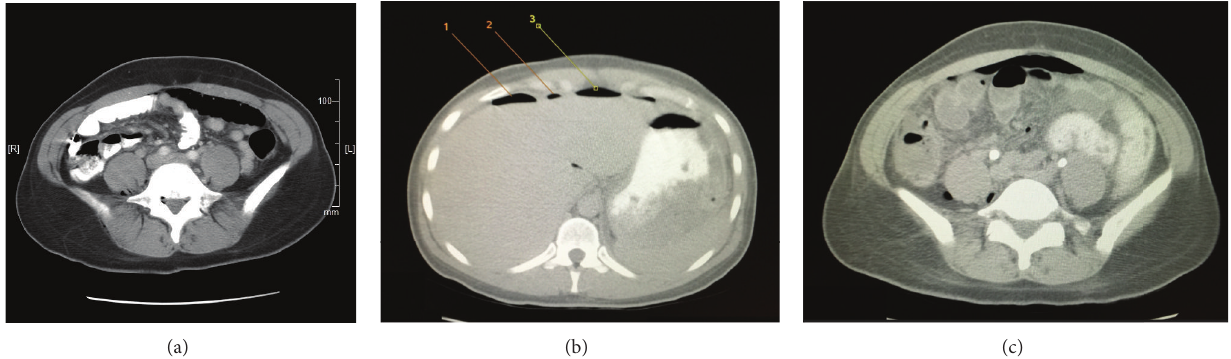
Figure 1: Computed tomography (CT) of the abdomen/pelvis demonstrates the progression of intra-abdominal injury and free air accumulation. (a) Transaxial view highlighting the accumulation of air in the spinal canal, psoas muscles, and the retroperitoneum, secondary to deep penetration and injury of the small bowel during the laminectomy. (b) This axial view demonstrates three distinct locations (labeled 1, 2, and 3) of intra-abdominal free air found on a follow-up CT of the abdomen/pelvis. (c) Axial view depicting extraluminal air anterior to the bowel, as well as air within the mesentery and posterior to the right psoas muscle.